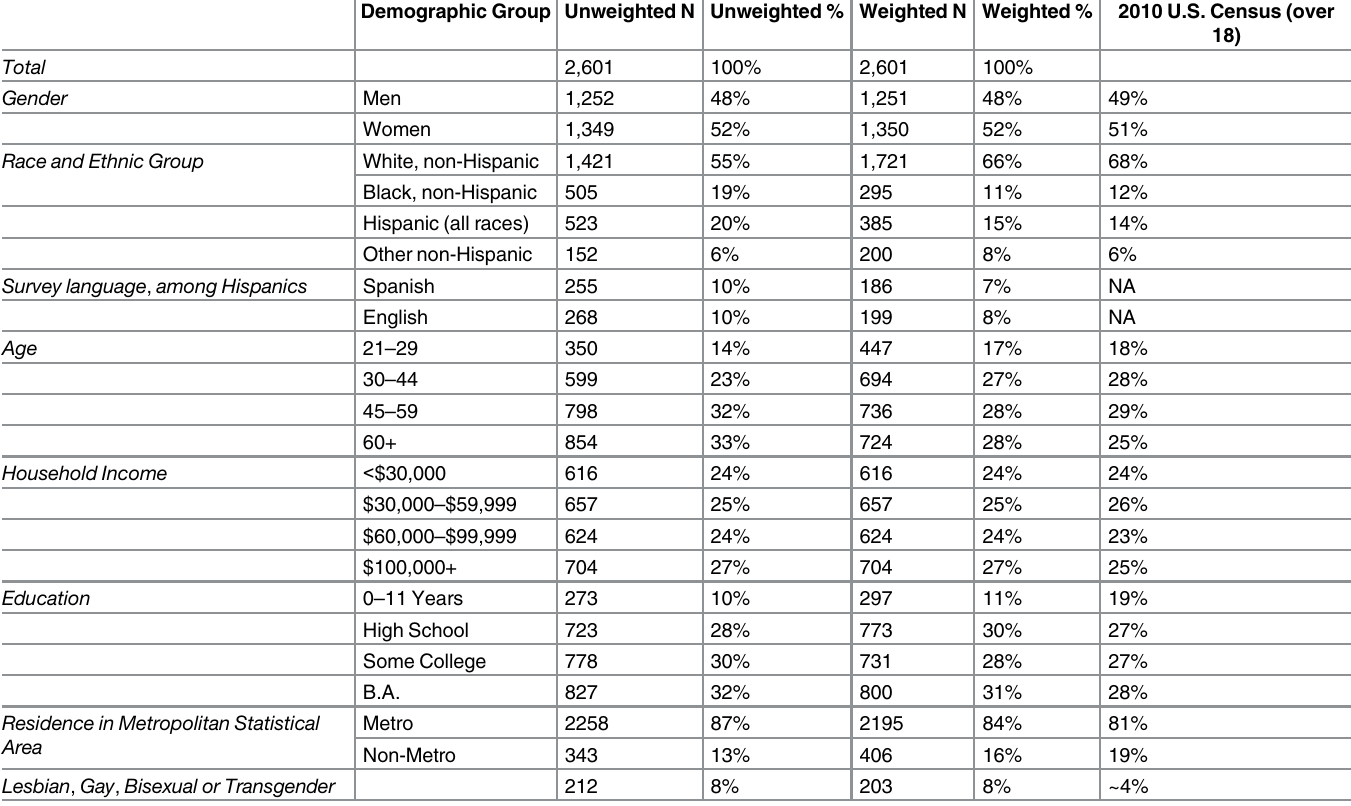
Table 1. Weighted and unweighted demographics of survey respondents, compared to 2010 U.S. Census figures. (n =